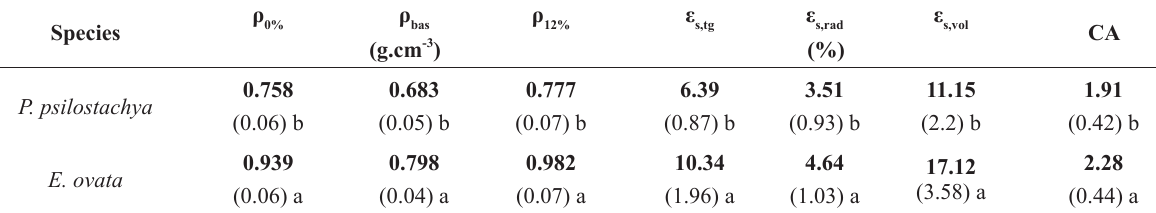
Wood physical properties of P. psilostachya and E. ovata. Mean values followed by standard deviation, between parentheses, and letters representing the statistical group, where different letters in the same column indicate significant statistical difference between treatments.